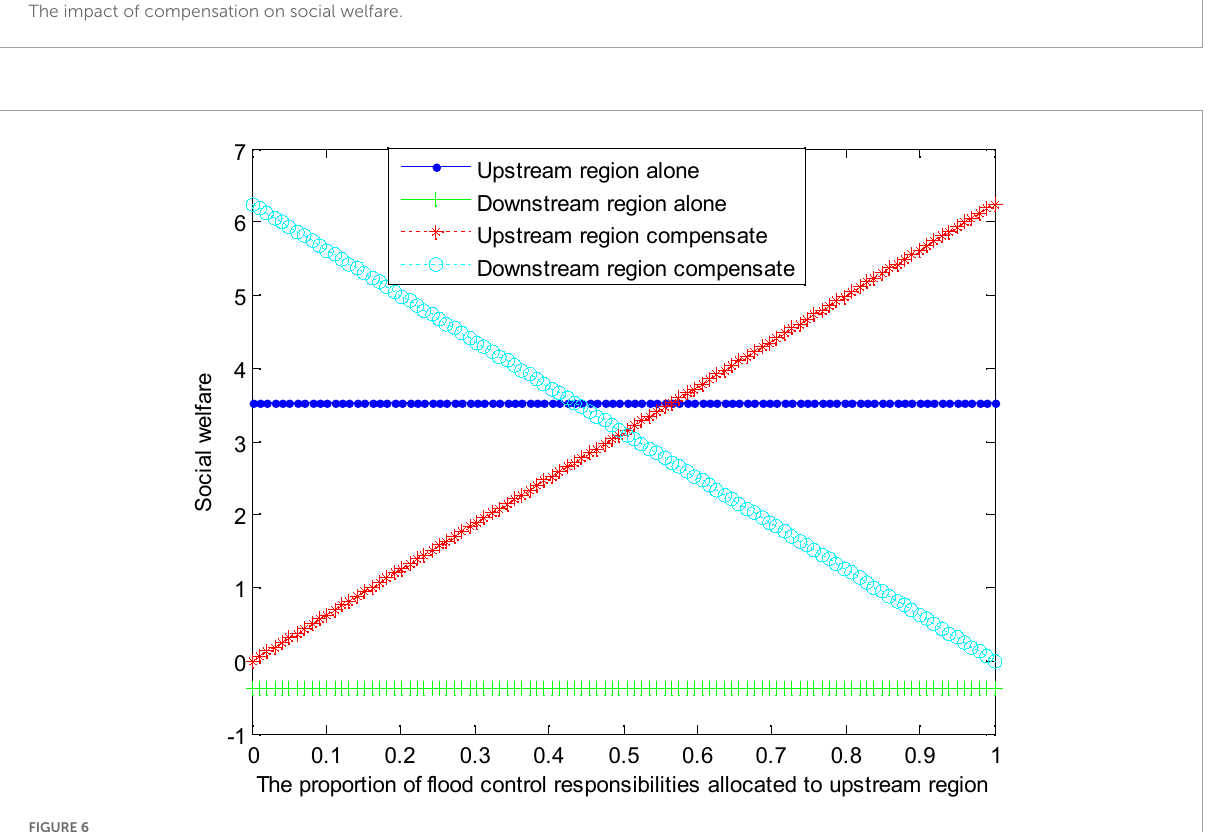
FIGURE6 The impact of allocation ratio on social